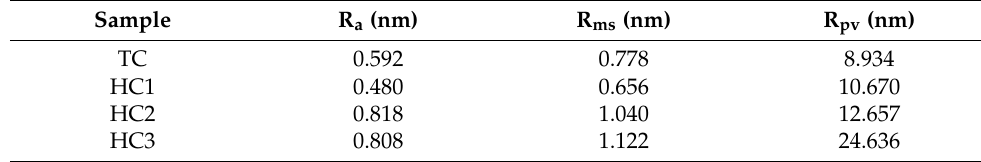
Table 1. The roughness parameters of the hybrid